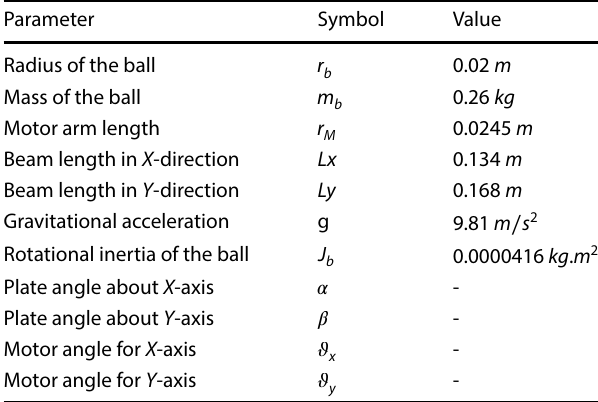
Table 1 BBT physical parameters [1]